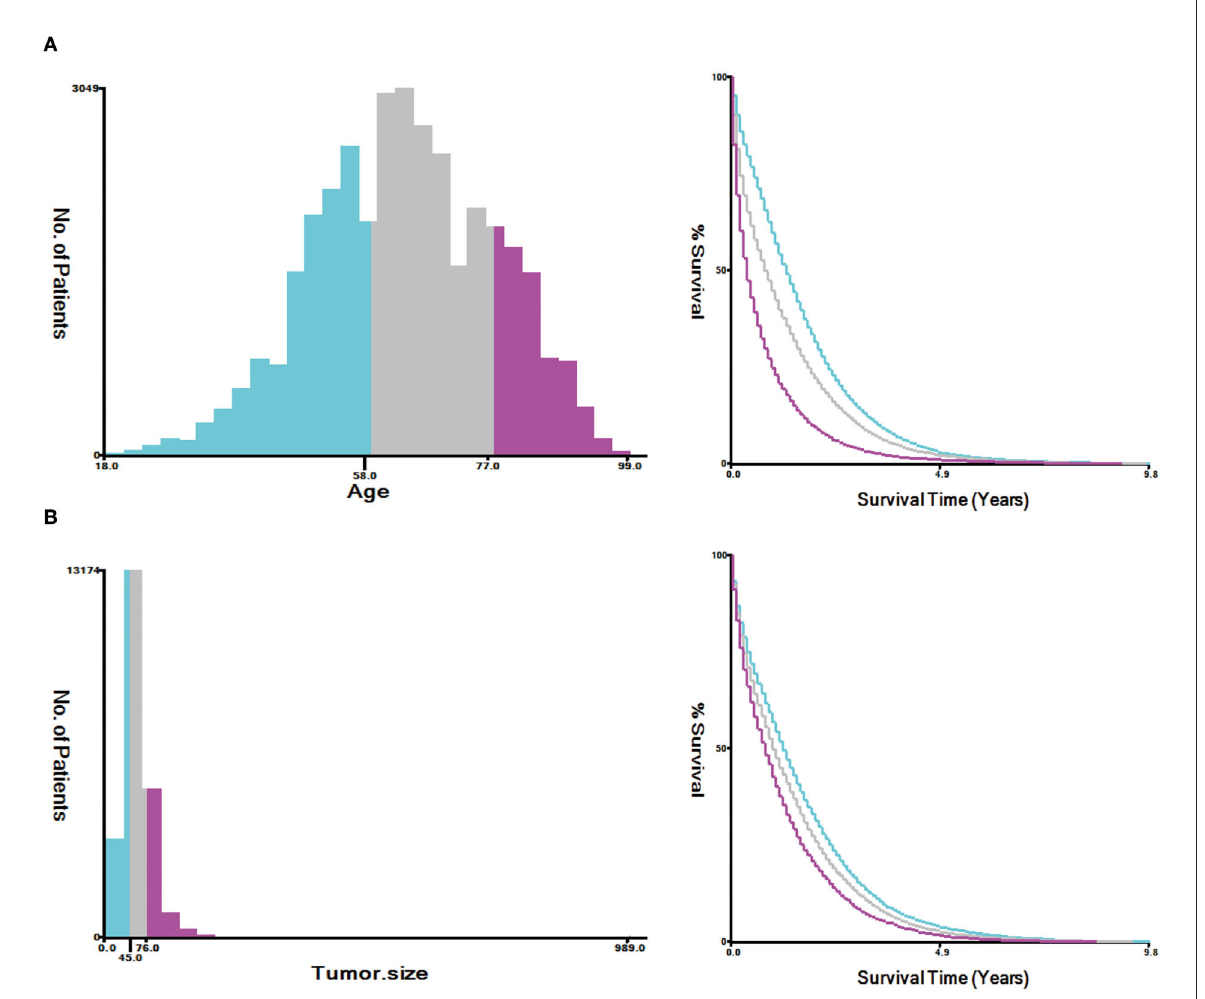
FIGURE2 Estimation of the appropriate cutoff value for age (A) and tumor size (B) by X-tile analysis.